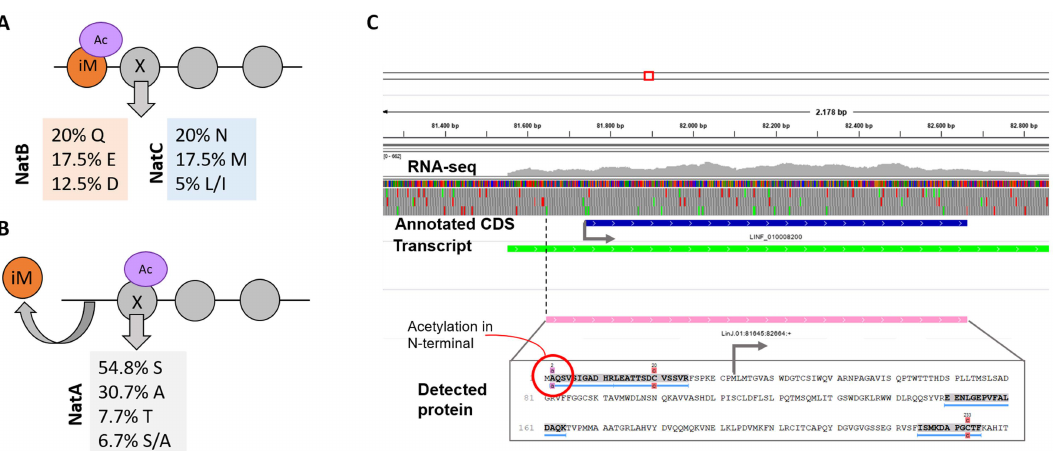
Figure 5. Features of the N-terminal acetylated proteins identified in this study. ( A ) Frequencies (percentages) of amino acids found next to the acetylated initial methionine (iM) and the putative enzymes responsible for the acetylation. ( B ) Percentages of amino acids found to be acetylated after cleavage of the iM and the putative enzyme involved in the reaction. ( C ) An example illustrating the usefulness of proteomics data for improving gene annotations. An acetylated peptide (red circle on the grey shaded sequence) was mapped to sequences located upstream of the currently annotated coding sequence for gene LINF_010008200 (blue box). The corrected gene (pink box) fit well into the transcript (green box). The image in ( C ) was generated using the Integrative Genome Viewer (IGV). CDS: coding